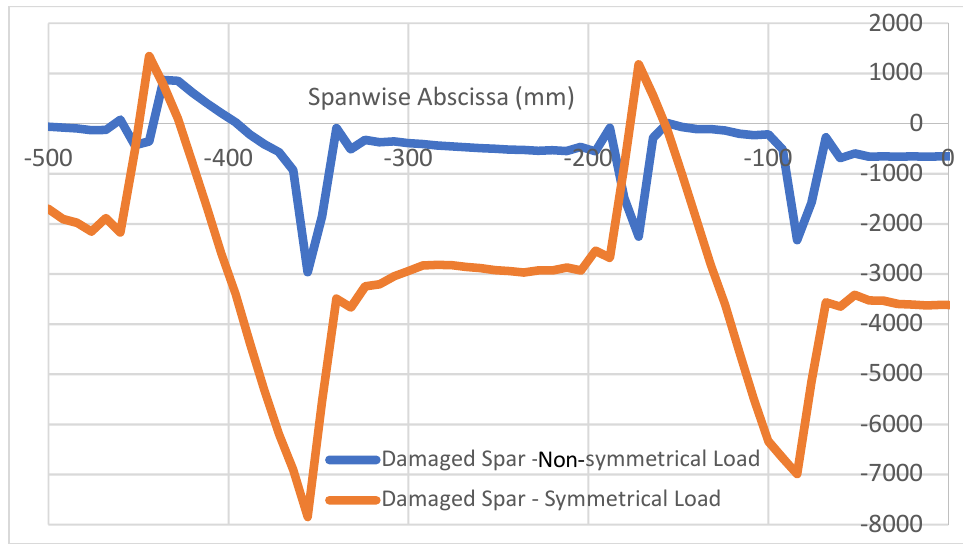
Figure 23. Comparison of damage array effects on deformation ( µε ) at two different stations deployed along the span of the beam. Reported spars are the ones where the flaws are deployed. Top and bottom caps of the referenced structure show significant differences in their